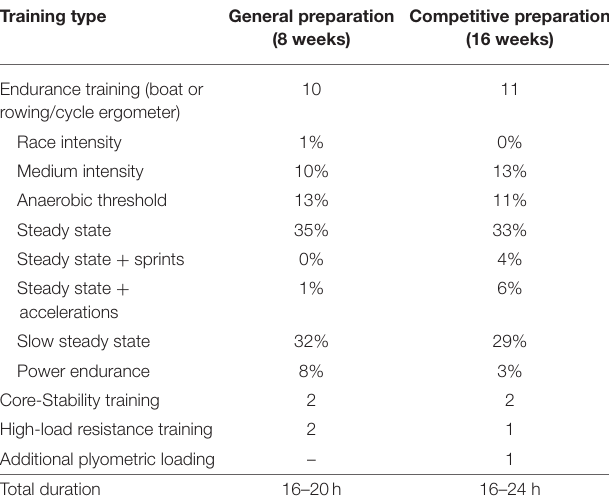
TABLE 1 | Training distribution during general preparation and competitive preparation in elite female rowers [training sessions per training (sub)type and total duration of training per